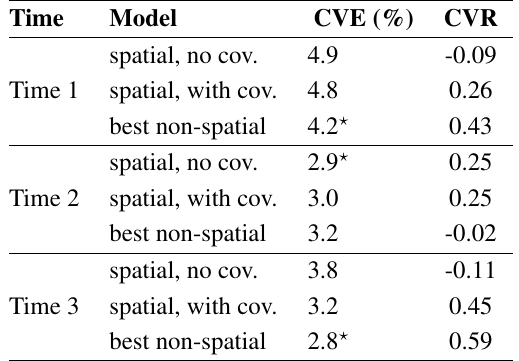
Table 7. Model validation statistics, comparing the relative performance of the best-fitting spatial versus non-spatial models. The best model(s) in terms of CVE, is (are) denoted by a